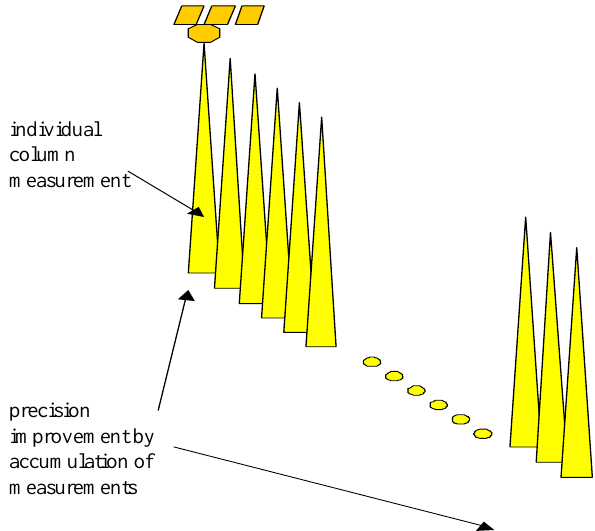
Fig. 1. Measurement alignment for a space-based nadir-viewing methane lidar. With the baseline lidar and platform parameters from Table 2, individual column measurements have a surface spot diam- eter of 135m and a precision of 10%. The columns are separated by 280m and hence do not overlap. All 177 measurements accu- mulated within a length of 50km have a precision of